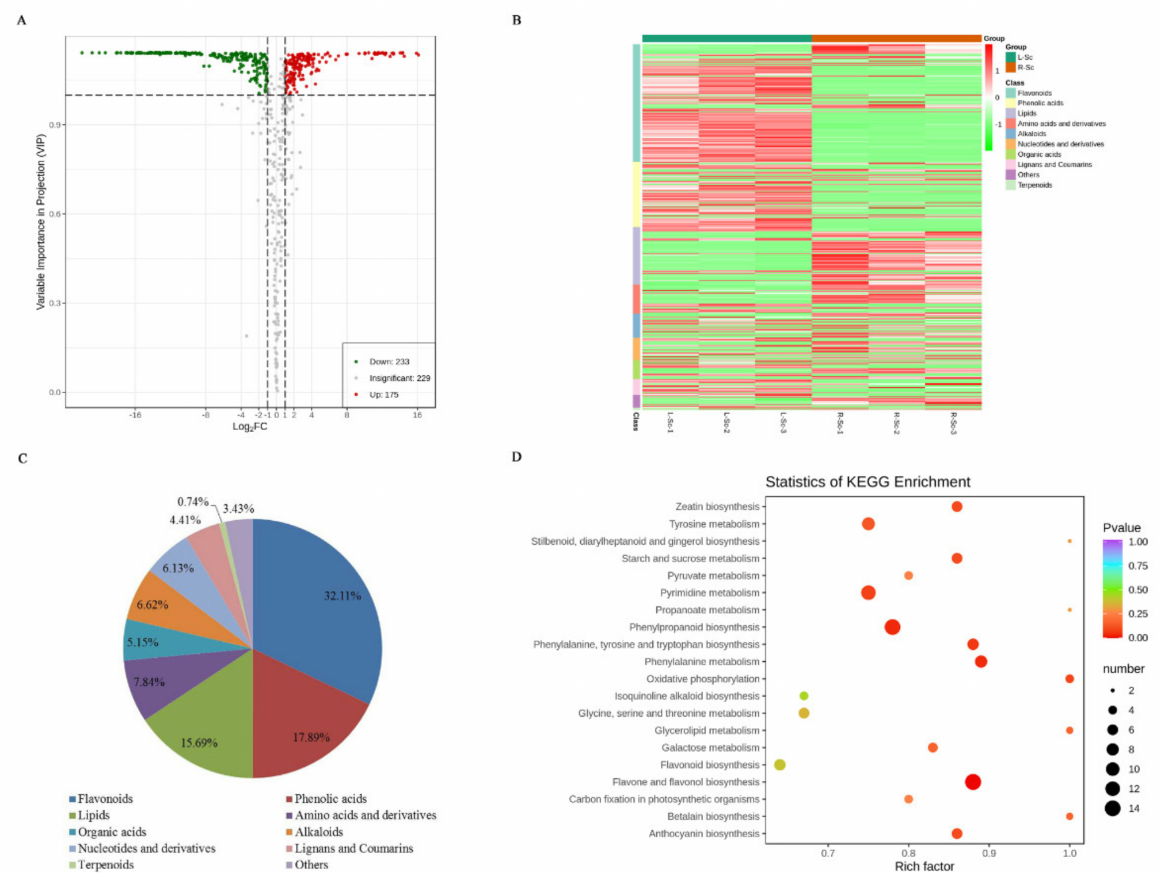
Figure 4. Differentially accumulated metabolites between L-Sc and R-Sc. ( A ) Volcano plot of the differential metabolites. ( B ) Heatmap of the differential metabolites. ( C ) Types and proportions of the differential metabolites. ( D ) Overview of KEGG pathway of the differential